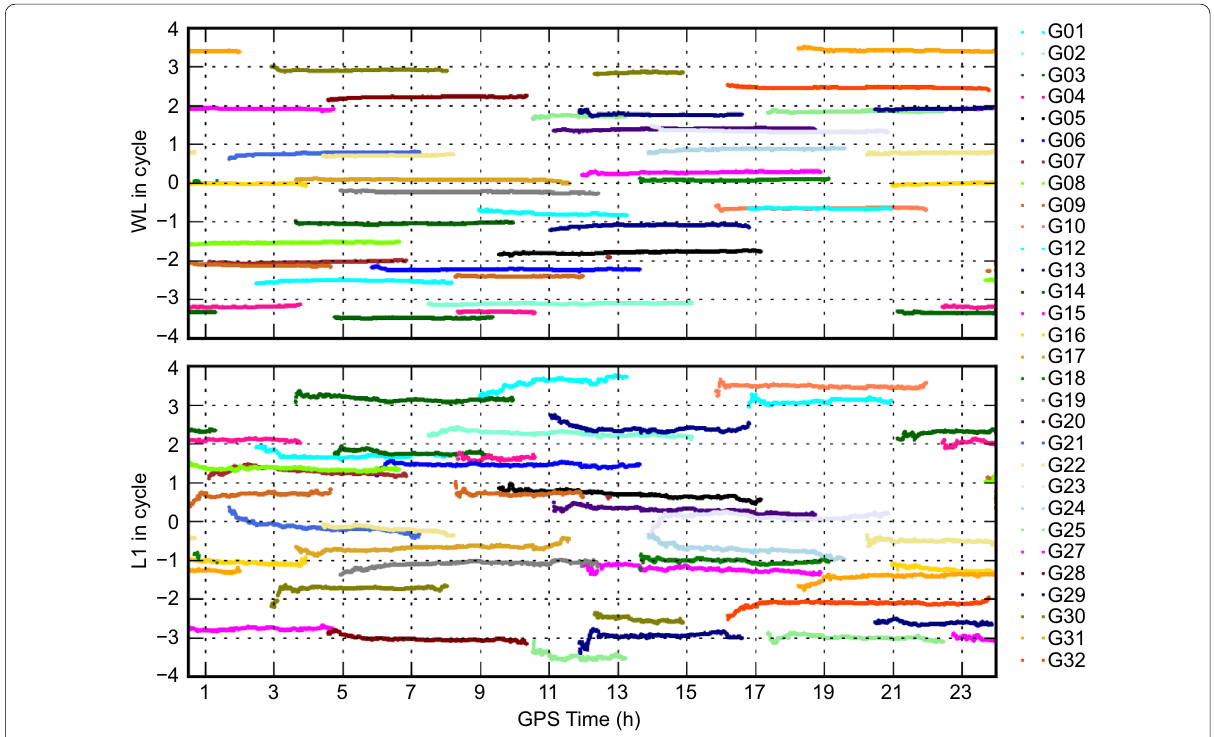
Fig. 4 Time series of hardware WL (top) and L1 biases (bottom) for GPS